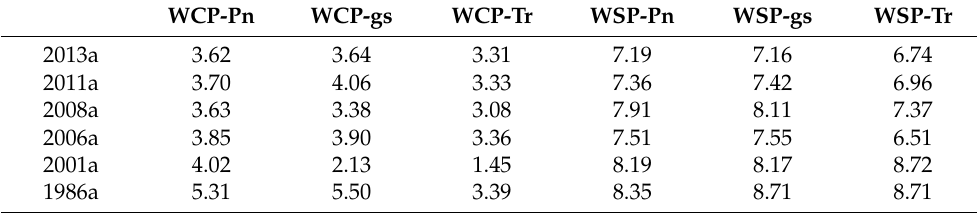
Figure 5. Regression fitting diagram of Tr and SWC. Table 4. SWC corresponding to extreme points of gas exchange parameters.